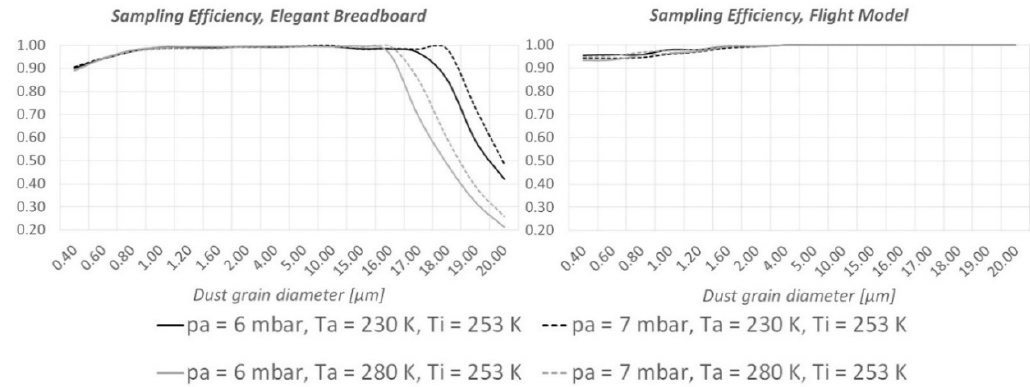
Figure 6. Comparison between the sampling efficiencies of MicroMED’s Elegant Breadboard and Flight Model for “cold instrument conditions” (T i = 253 K) .